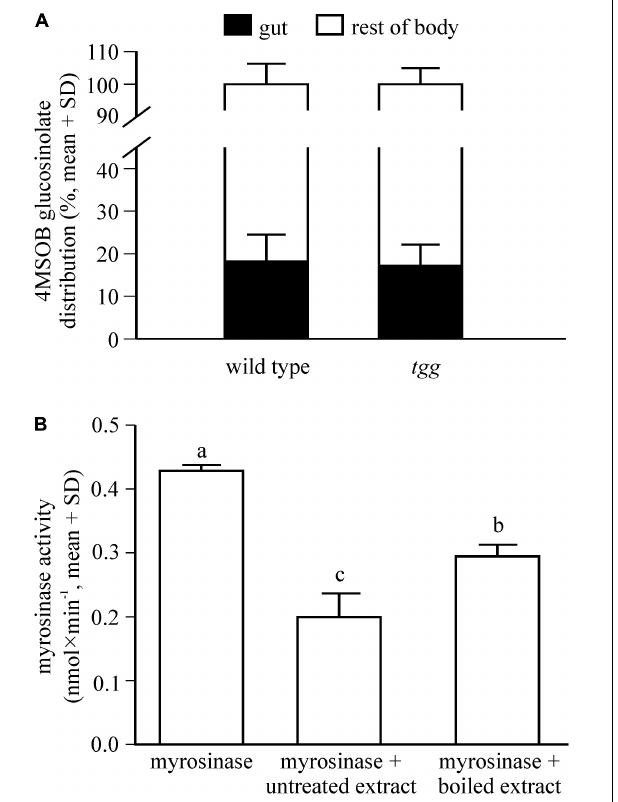
FIGURE 4 | Distribution of 4MSOB glucosinolate in the body of adult P. armoraciae beetles shortly after ingestion (A) and influence of beetle gut content extracts on plant myrosinase activity in in vitro enzyme assays (B) . (A) Beetles were allowed to feed for 1 min on Arabidopsis leaves with (wild type) or without ( tgg ) myrosinase activity and were dissected into gut and rest of body 5 min later ( n = 3 per plant genotype). Beetles were extracted with 80% methanol and 4MSOB glucosinolate was quantified by LC-MS/MS using an external standard curve. The distribution of 4MSOB glucosinolate in gut and rest of body is expressed relative to the total amount detected in both samples (set to 100%). (B) Enzyme assays were performed with partially purified Sinapis alba myrosinase that was incubated with 4MSOB glucosinolate as a substrate in the presence of untreated gut content extract of P. armoraciae , boiled gut content extract, or buffer ( n = 4 per treatment). Myrosinase activity was determined by quantifying the 4MSOB glucosinolate substrate in each assay after conversion to desulfo-glucosinolate and analysis by HPLC-DAD. Assays without myrosinase served as background controls and activities were subtracted from the corresponding samples. Myrosinase activity was compared by One-way ANOVA ( p < 0.001). Different letters indicate significant differences between groups. The result of the statistical analysis is shown in Supplementary Table 1